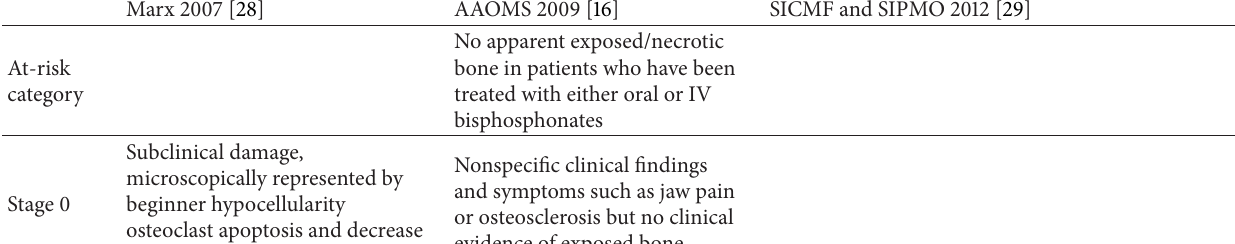
Table 1: Summary of different clinical BRONJ staging.